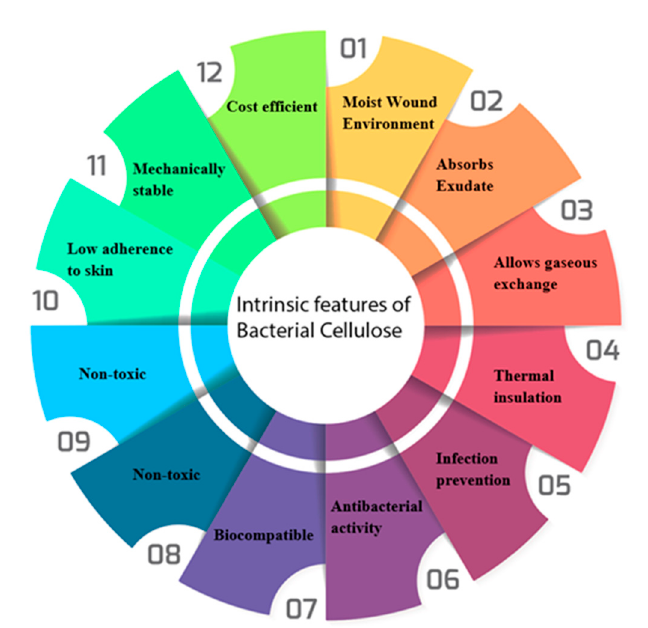
Figure 4. Core intrinsic properties that wound dressings should meet in order to be both commercially and therapeutically successful .